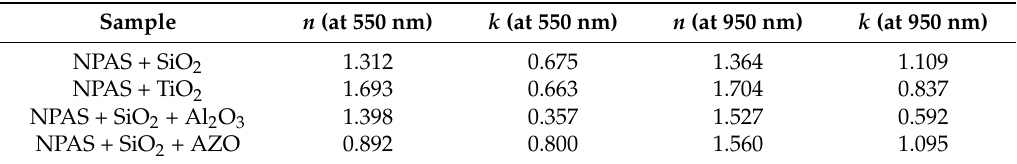
Figure 6. Wavelength dependence of ( a ) the refraction index, n , and ( b ) the extinction coefficient, k , for the NPAS + SiO 2 (cyan), NPAS + TiO 2 (black), NPAS + SiO 2 + Al 2 O 3 (dark yellow), and NPAS + SiO 2 + AZO (pink) samples. Table 4. Values of the refractive index, n , and extinction coefficient, k , at two wavelengths (550 and 950 nm) for the studied nanoporous alumina based structures.